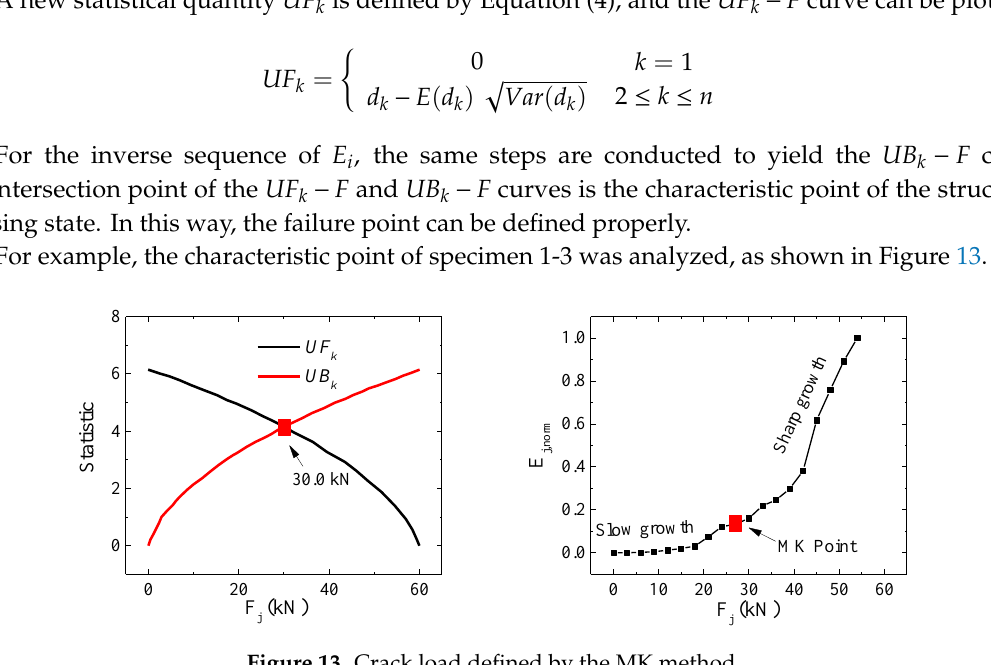
Figure 13. Crack load defined by the MK method.